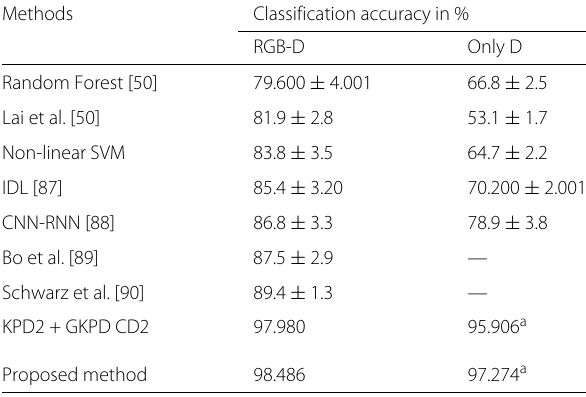
Table 3 Comparison of classification rate on Washington RGB-D Objects